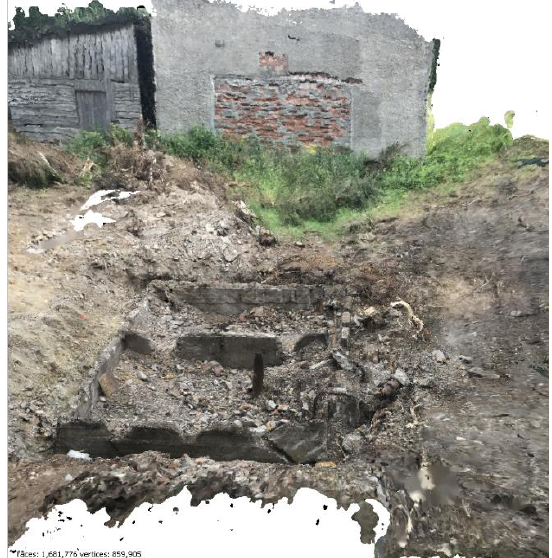
Figure 19. Using modern cameras mounted in